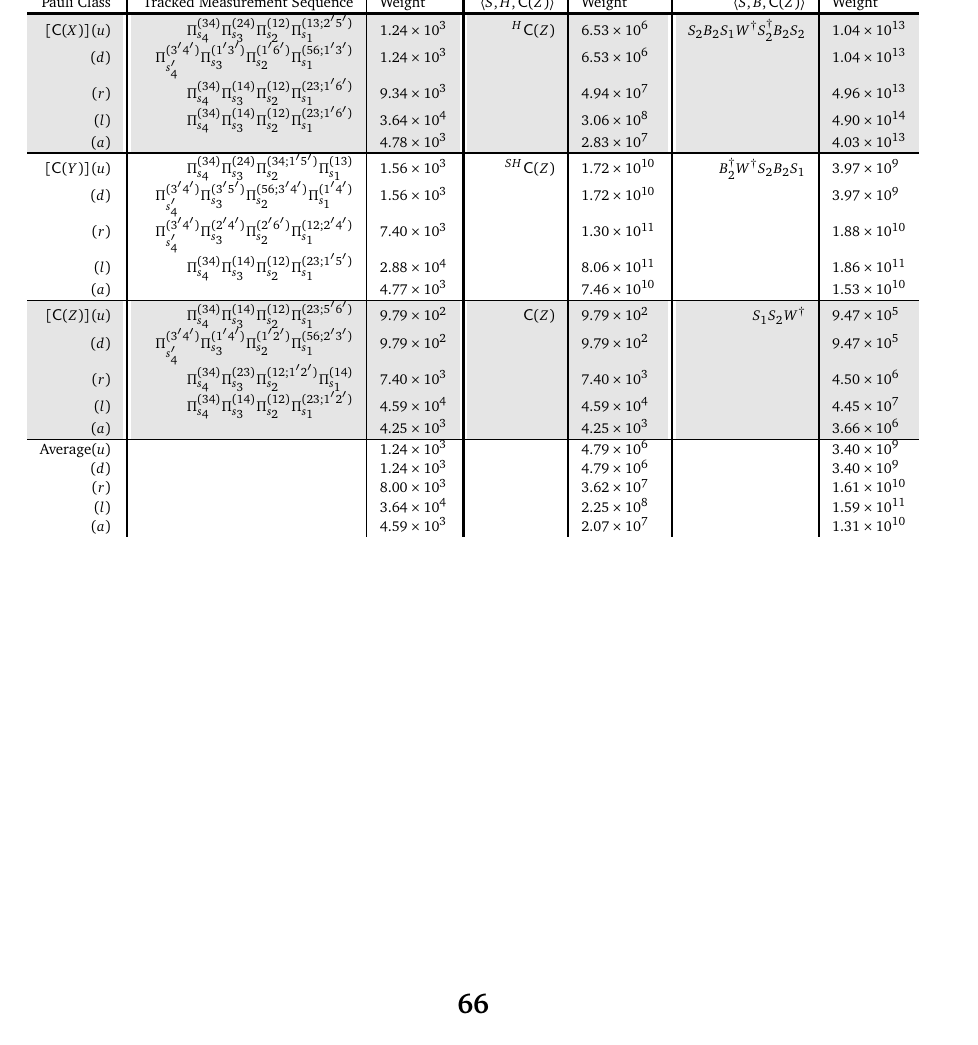
Table 25: Minimal difficulty weight measurement sequences for Pauli cosets of controlled-Pauli two-qubit gates when using Majorana-Pauli tracking methods. The labels ( u ) , ( d ) , ( r ) , and ( l ) indicates that for a hexon acting as the control qubit of the C ( P ) gate, the corresponding target qubit is the nearest neighbor hexon in the up, down, right, and left direction, respectively. Notice that the choice of control and target qubit is arbitrary for C ( Z ) , so ( u ) and ( d ) are related by symmetry, as are ( r ) , and ( l ) . The average difficulty weight of the four directions is labeled by ( a ) . For comparison, we also present the corresponding realization of the gates formed by using the generating gate sets 〈 S , H , C ( Z ) 〉 and 〈 S , B , W 〉 . A C ( Z ) = A C ( Z ) A † denotes conjugation of C ( Z ) by A on the target qubit. 2 2 Pauli Class Tracked Measurement Sequence